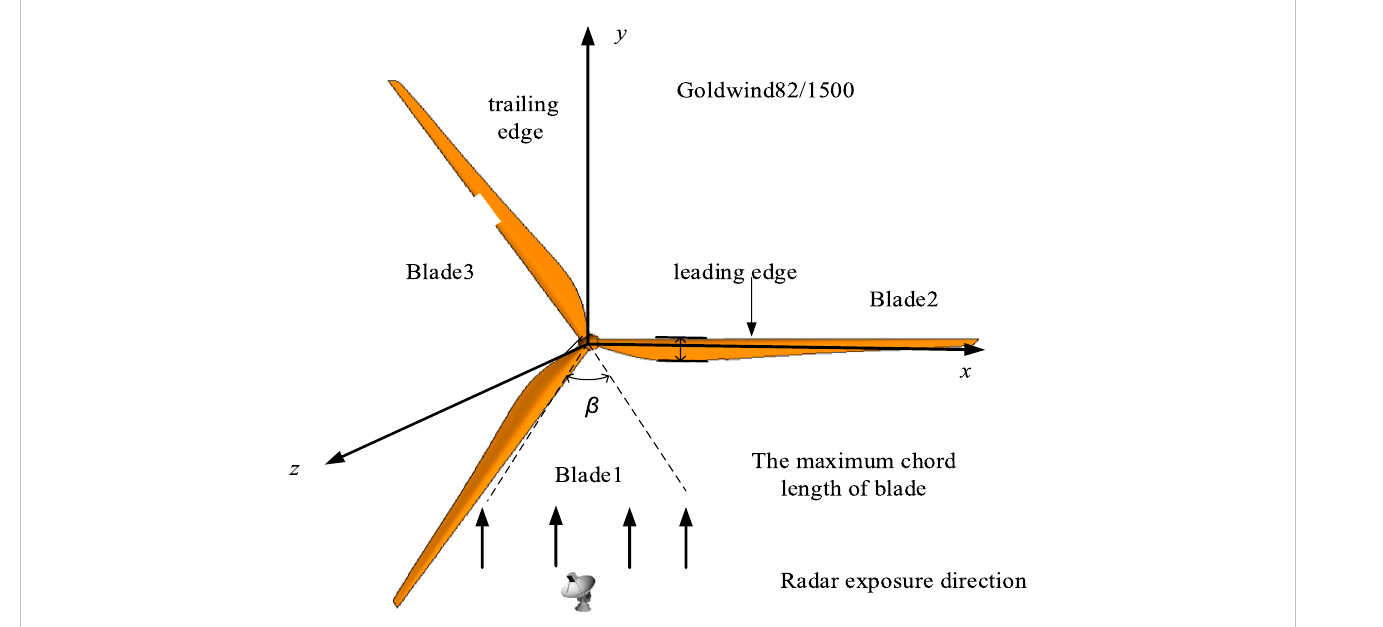
FIGURE 3 Geometry model of Goldwind82/1500 WT